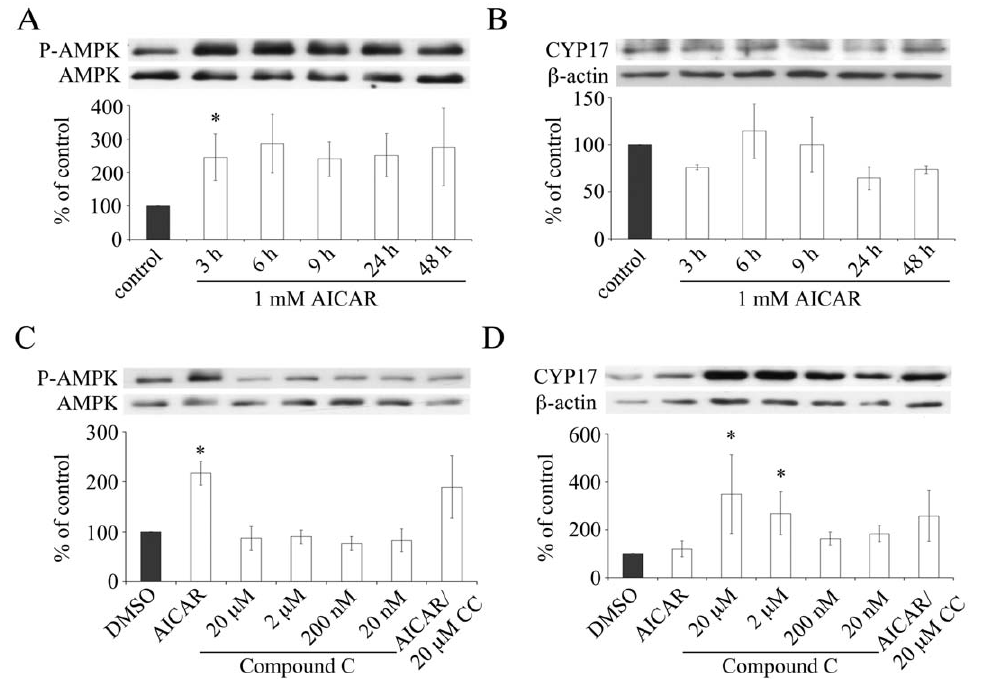
Figure 5. Effect of AICAR and compound C on phosphorylation of AMPK and on CYP17 expression in NCI-H295R cells. A–D, cells were treated and protein extracts were prepared and analyzed by Western blot. A–B, NCI-H295R cells were stimulated with 1 mM AICAR for 3–48 h. An increase in AMPK phosphorylation was noted after 3 hours (A) while CYP17 expression remained unchanged (B). C–D, NCI-H295R cells were treated with 20 nM–20 m M compound C (Comp C), 1 mM AICAR or with both for 48 h. Note that compound C attenuated AICAR stimulated AMPK phosphorylation (C) and increased CYP17 expression at higher concentrations (D). Representative Western blots of two to three independent experiments are shown. b -actin served as loading control. Quantitative results are given as mean 6